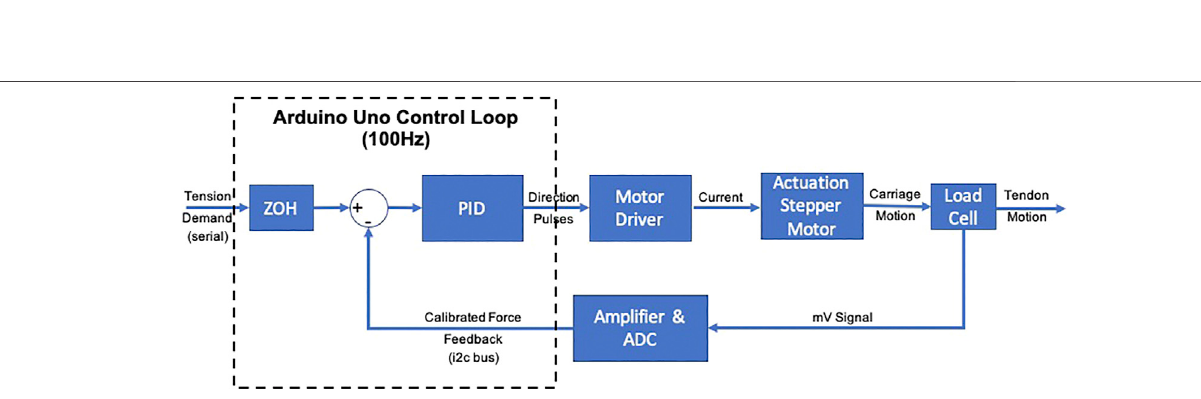
Frontiers in Robotics and AI |